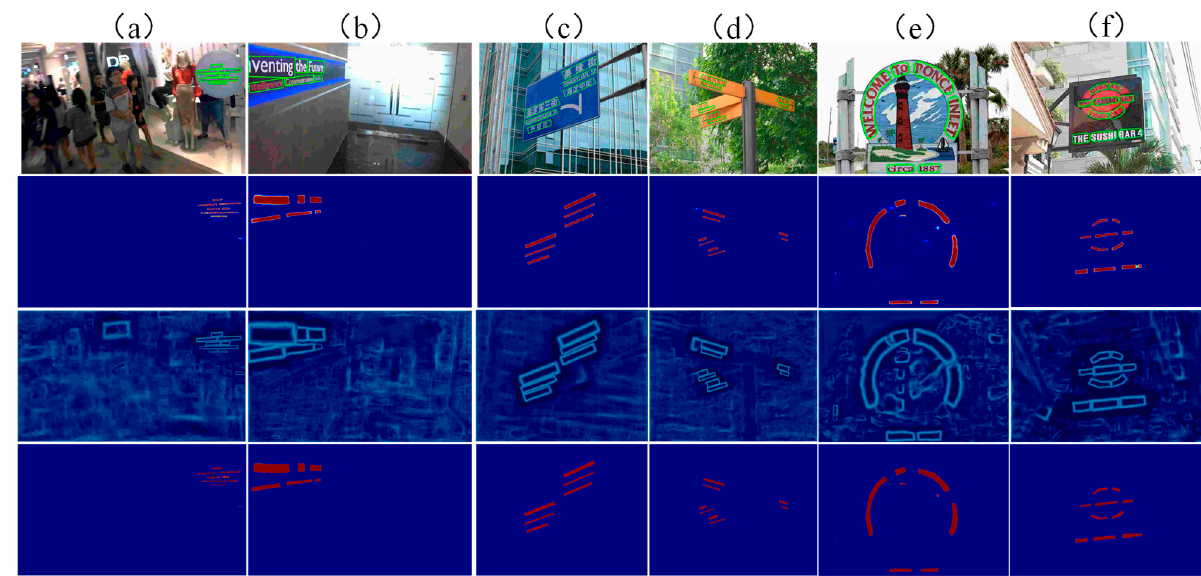
Figure 5. Visualization results of different types of text examples. Where ( a ) and ( b ) are multi-directional texts, ( c ) and ( d ) are multi-lingual texts, ( e ) and ( f ) are curved texts.